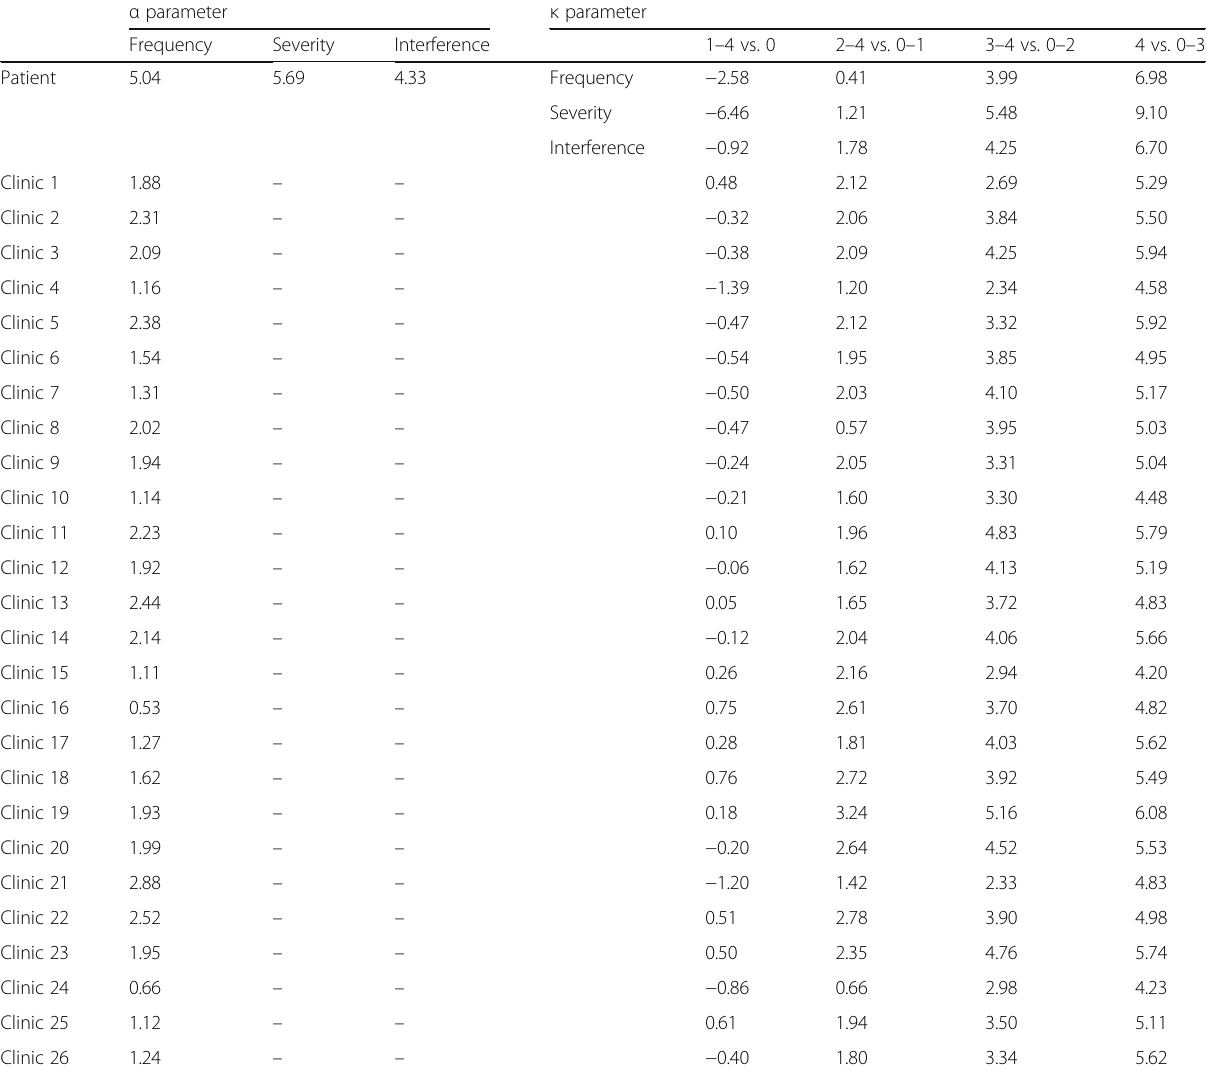
Table 6 Bayesian Graded Response Model Estimates for